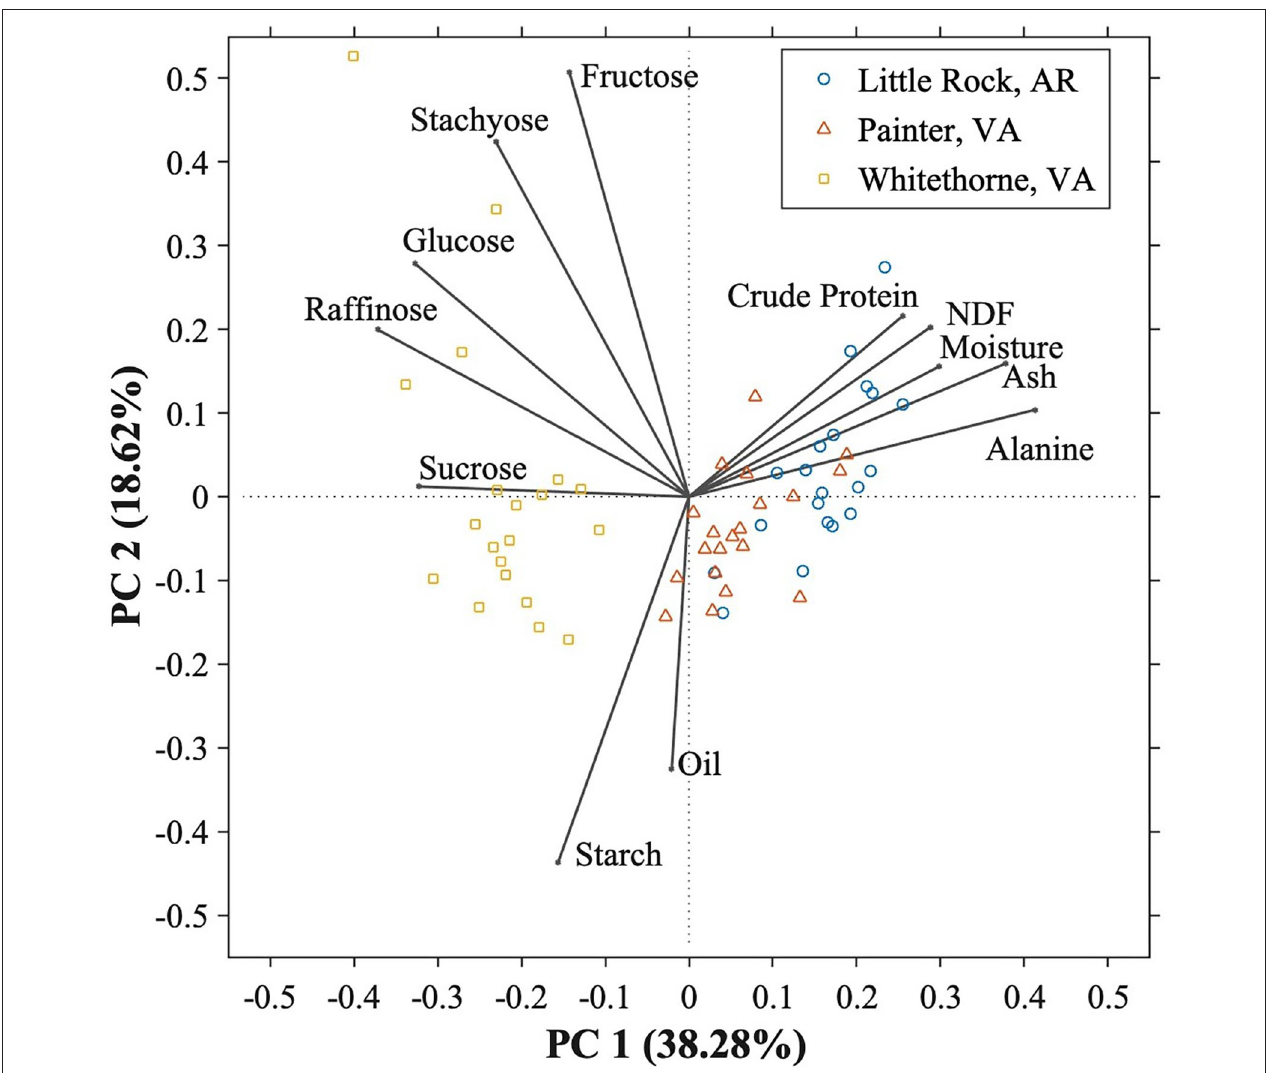
FIGURE 1 | Principal component analysis (PCA) score plot and the component loading plot of PC1 vs. PC2 of the 10 different edamame genotypes planted in three different locations.